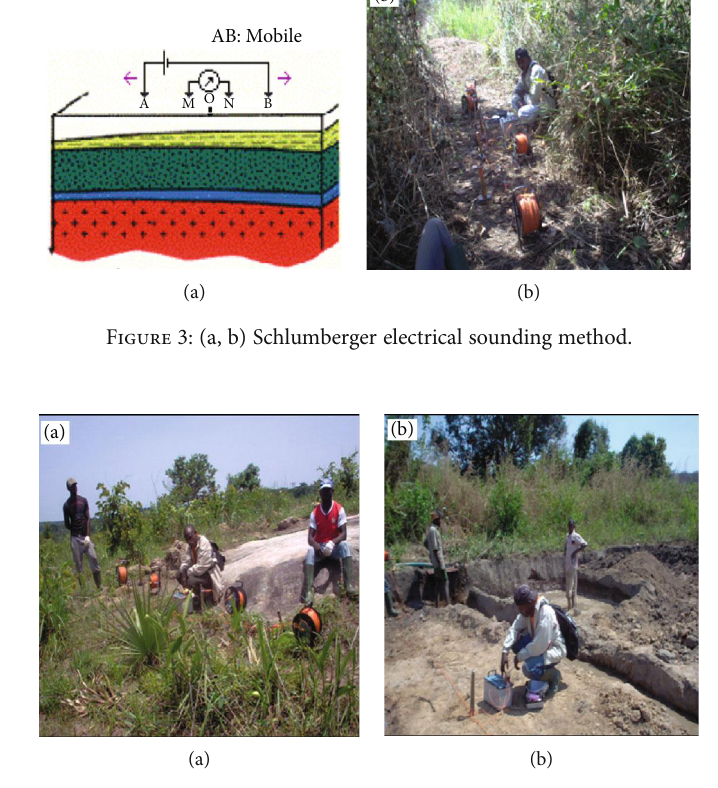
Figure 4: Electrical sounding test near the granite outcrop (a) and the mining site